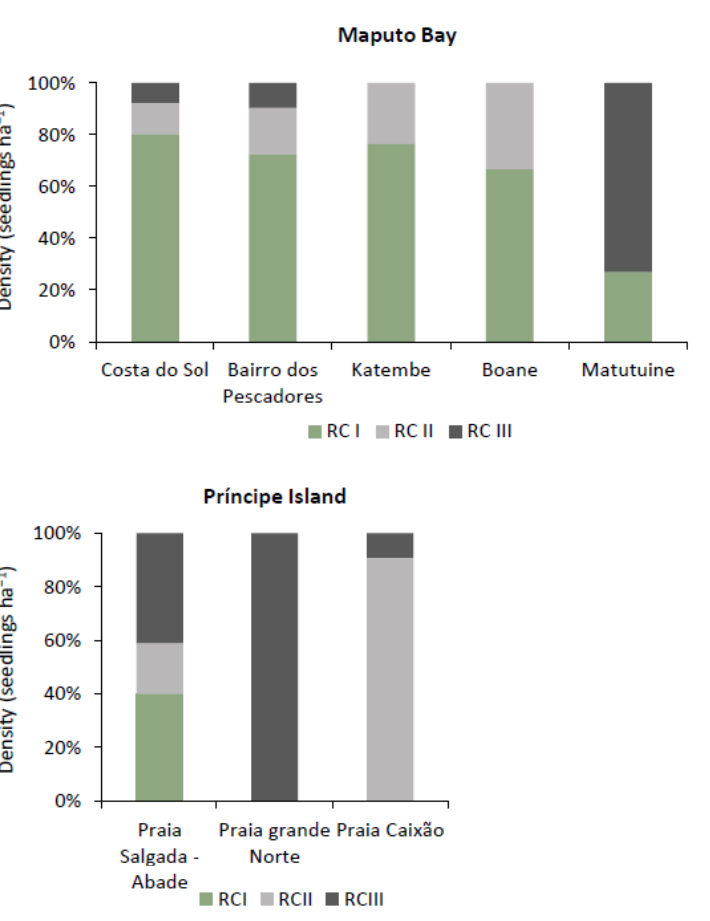
Figure 7. Regeneration rate in Maputo Bay and Pr í ncipe Island. RCI–regeneration class I, RCII– Regeneration class II and RCIII–Regeneration class III. Table 5. Use of mangrove resources by gender in Maputo Bay and Pr í ncipe